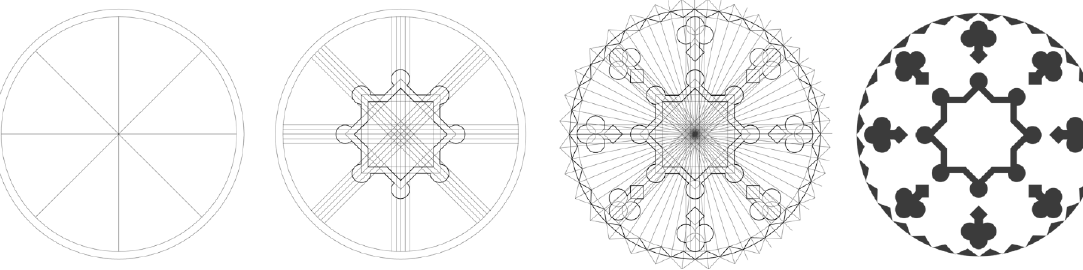
Figure 3. Figure-Ground